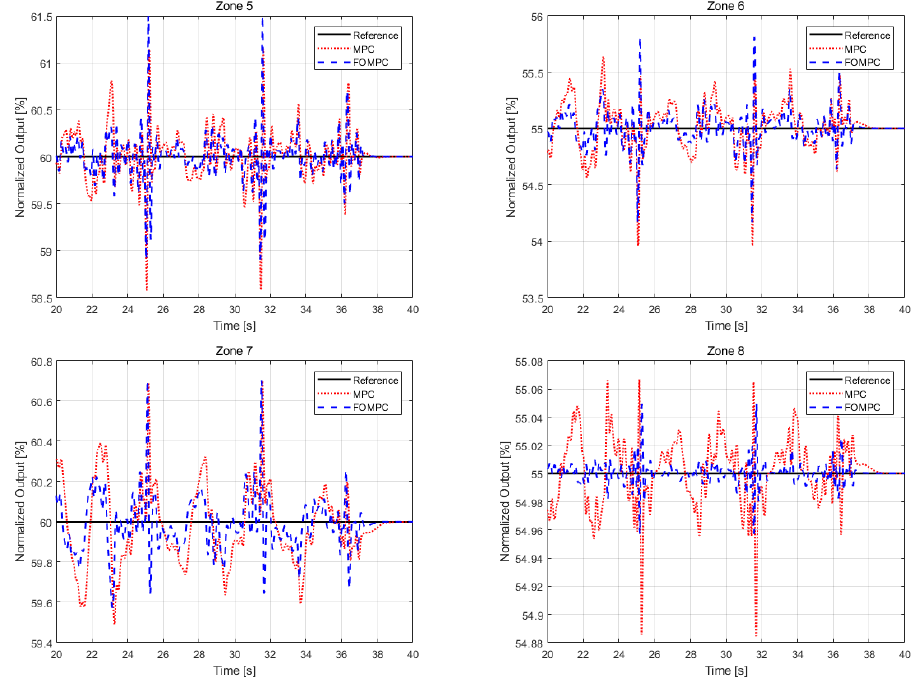
Figure 6. Comparison of disturbance rejection performance between MPC and FOMPC.